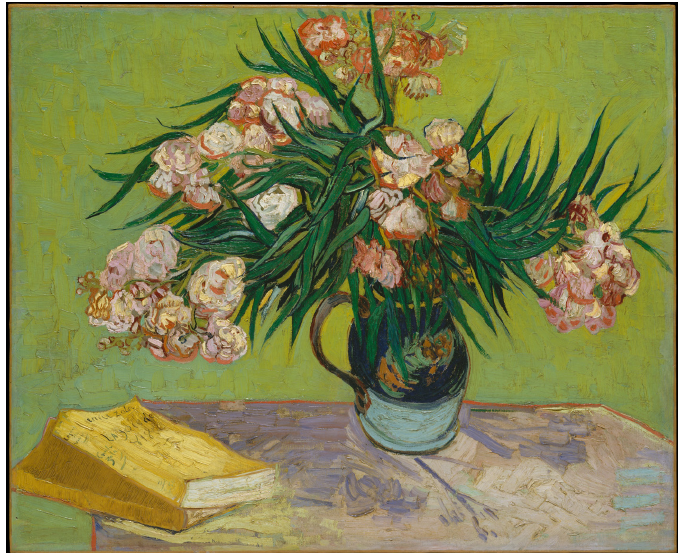
Fig. 7 : Vincent Van Gogh, Oleanders , 1888, oil on canvas, 60.3 × 73.7 cm, Metropolitan Museum of Art, New York. Gift of Mr and Mrs John L. Loeb, 1962,